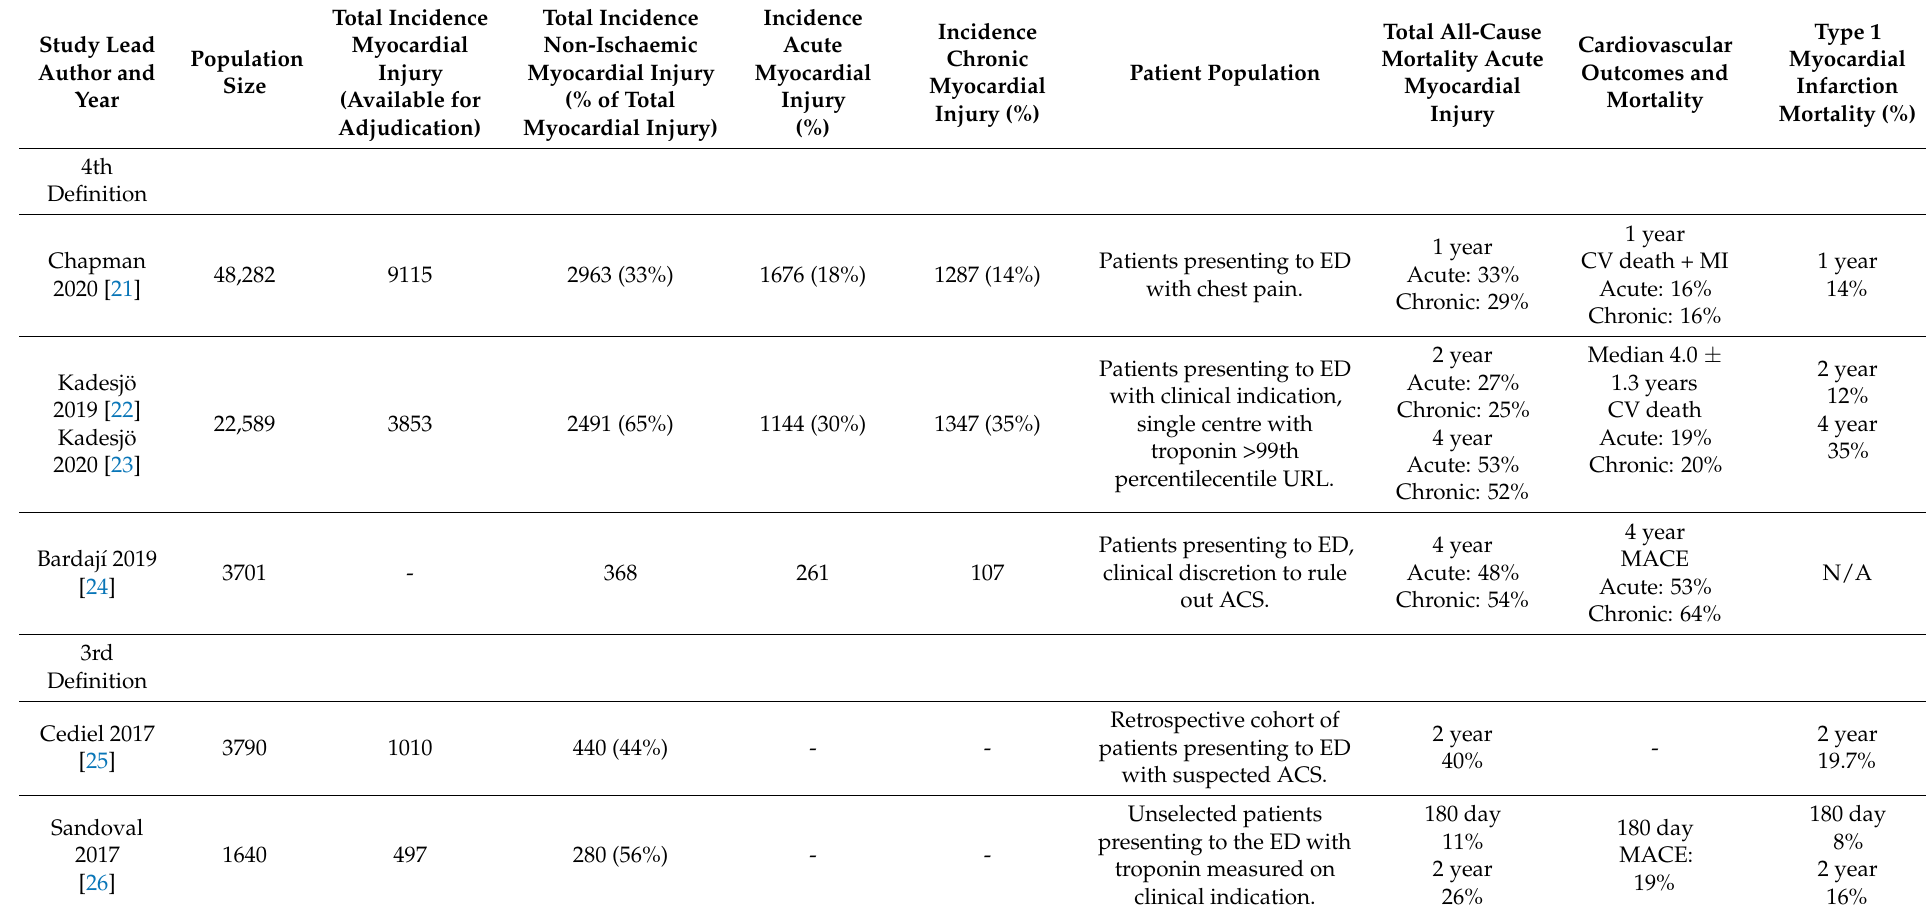
Table 1. Table illustrating incidence of myocardial injury as per the universal definition over population subsets, proportion of non-ischaemic myocardial injury, cardiovascular and total mortality